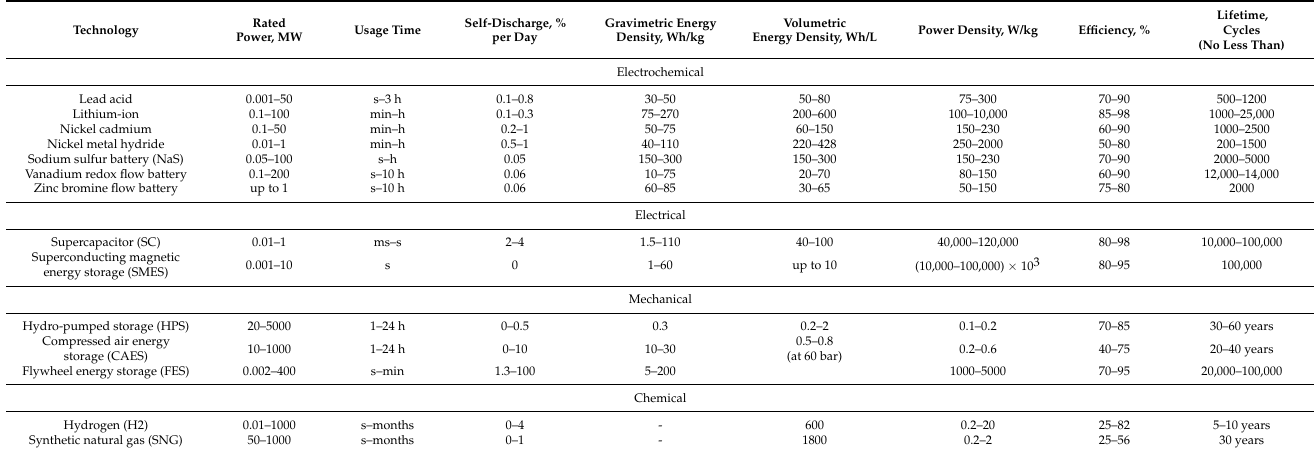
Table 1. Characteristics of existing EES technologies.